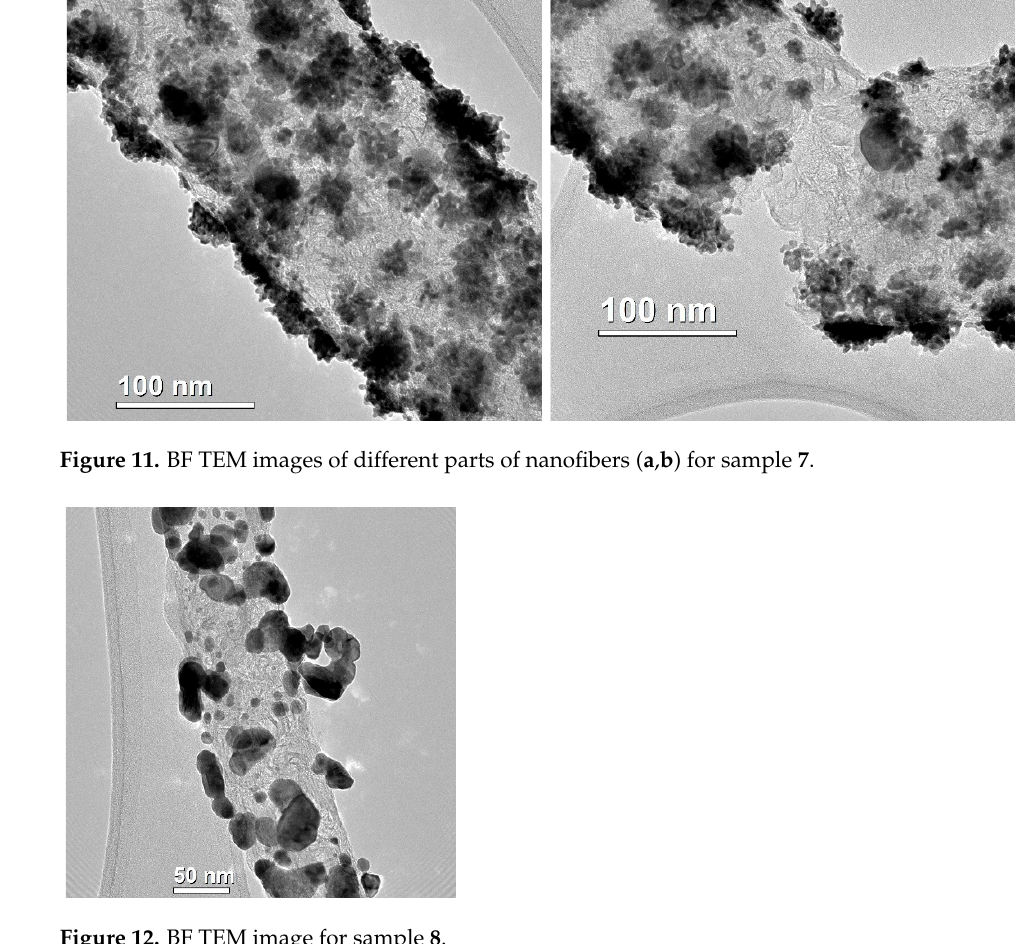
Figure 12. BF TEM image for sample 8 .